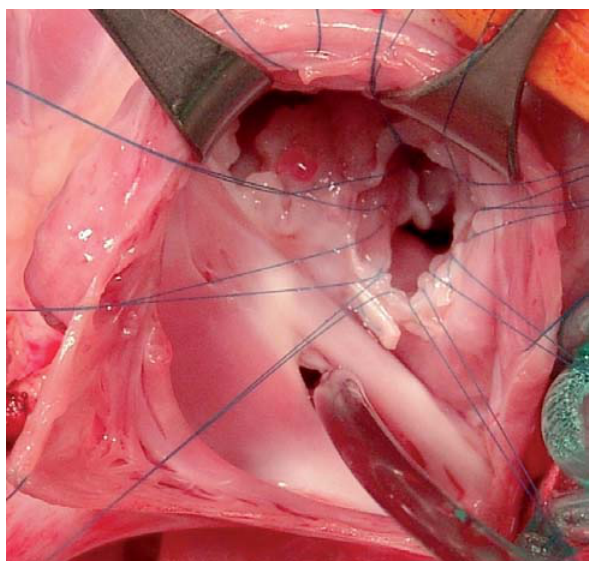
Fig. 1 – Átrio direito aberto onde se observa a